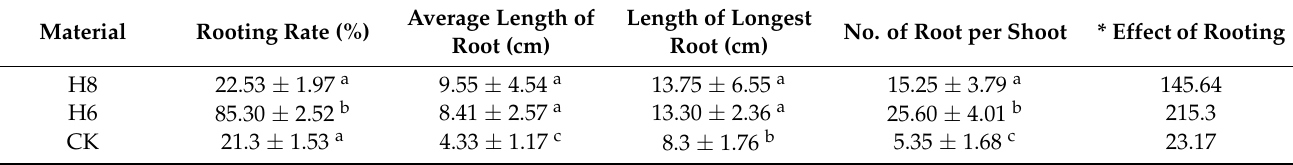
Table 1. Comparison of rooting ability of two E. ulmoides improved varieties 1